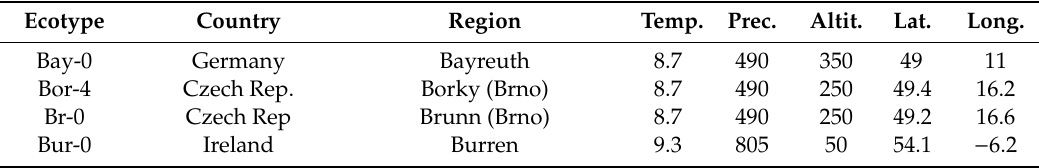
Table 1. List of ecotypes used in this study including abbreviations, country and region of origin of each ecotype. Listed are also main environmental parameters for each site of origin: Mean year temperature in ◦ C (Temp.), Mean total annual precipitation in mm (Prec.), Mean altitude (Altit.) and precise geographical location—Latitude and Longitude (Lat.,